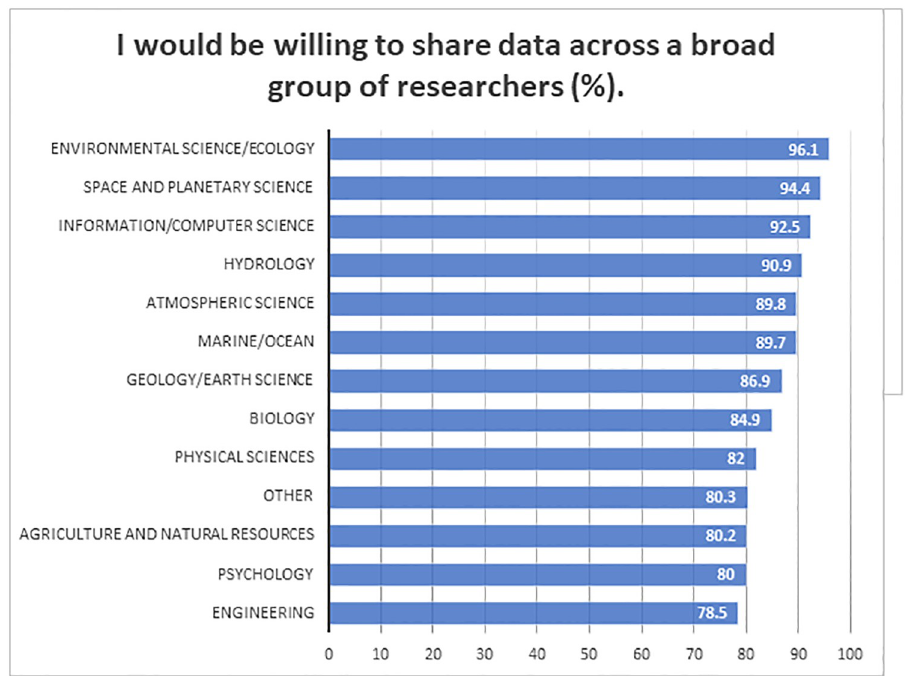
Fig 7. Cross between “primary subject discipline” and “I would be willing to share data across a broad group of researchers (n = 1776).